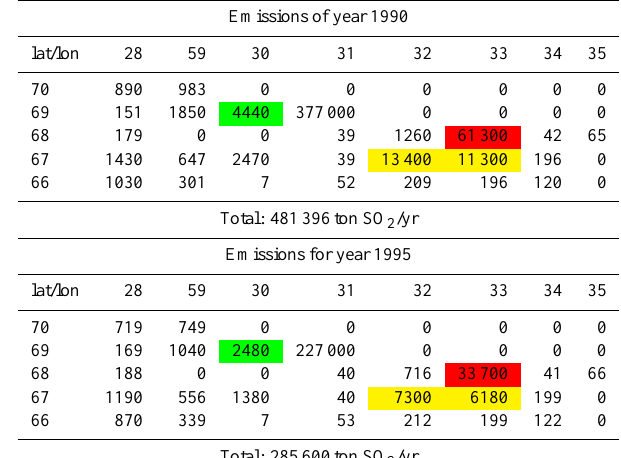
Table 3. EDGAR SO 2 emissions (Unit: tons of SO 2 yr − 1 ). Grid cells containing the largest sources have been highlighted (green - Nikel, red - Murmansk, yellow –